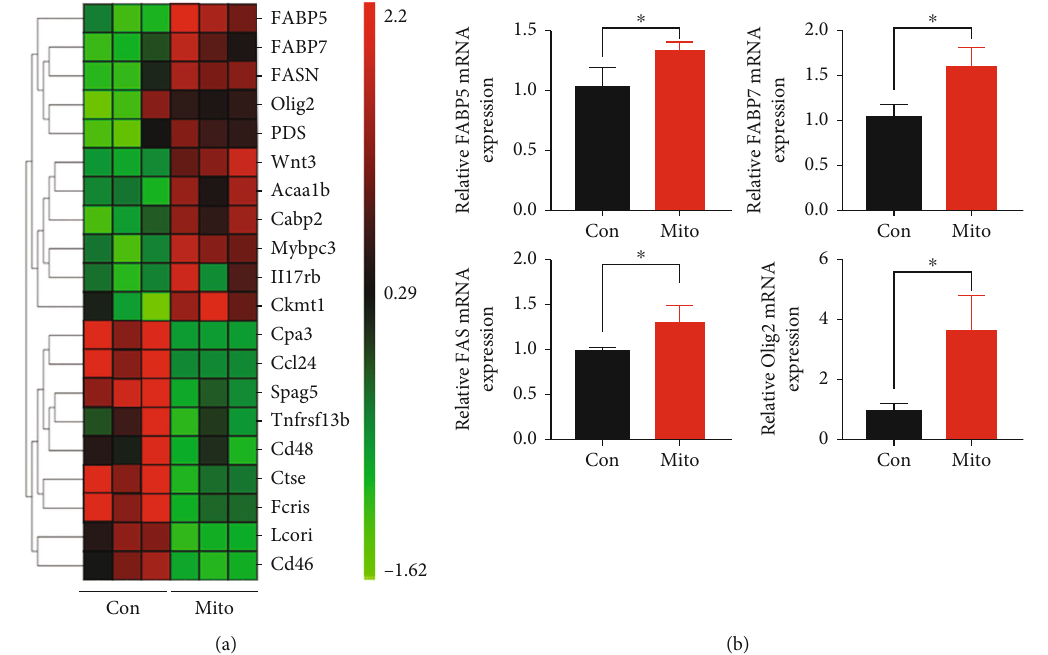
Figure 5: Transcriptome analysis of mitochondria-treated cortex and validation of top increased genes. (a) Heatmap of top changed genes. (b) qPCR validation of top increased genes. Notice that the mRNA levels of FABP5, FABP7, FASN, and Olig2 were signi fi cantly increased in mitochondria-treated cortex. Student ’ s t test for (b). N = 3 mice per group. ∗ P < 0 : 05